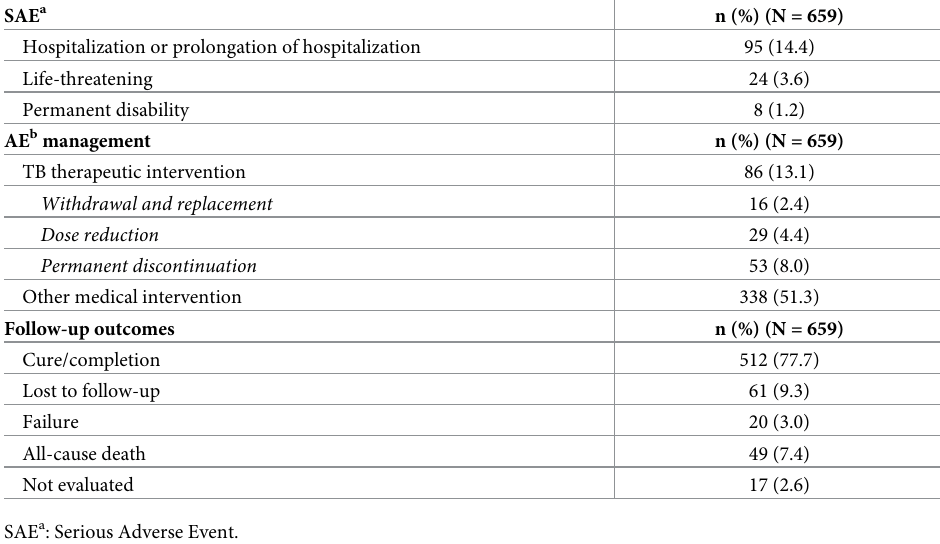
Table 3. Consequences of the adverse events and follow up outcomes of MDR-TB treatment.